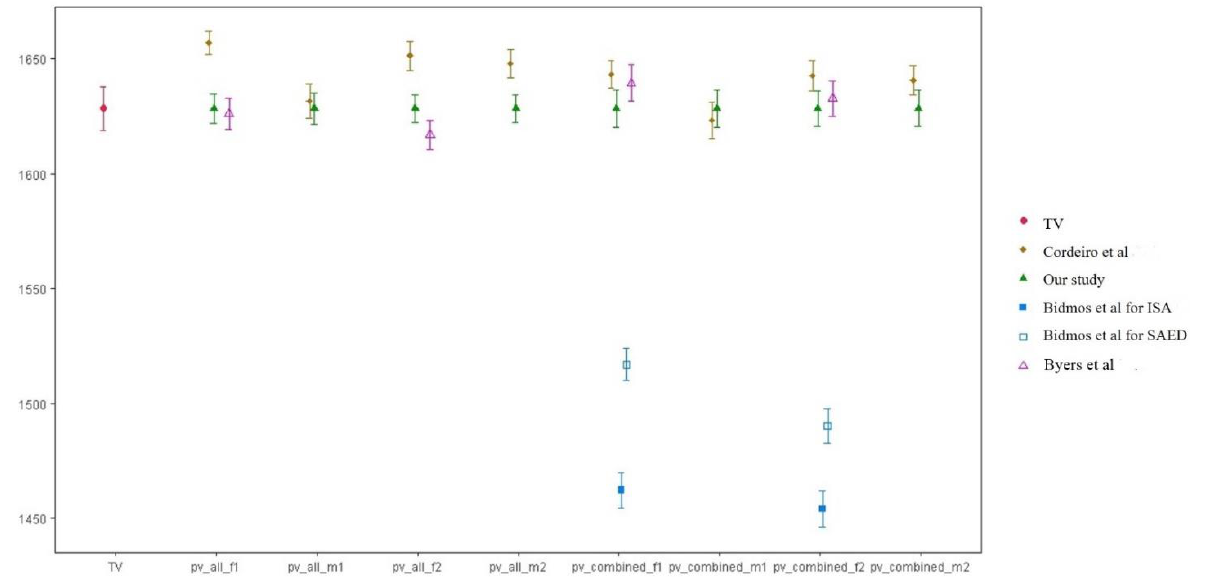
length; all, unknown sex; combined, males and females combined; ISA, indigenous South African; African; SAED, South Africans of European descent. Cordeiro, et al. [14], Bidmos, et al. [13], Byers,